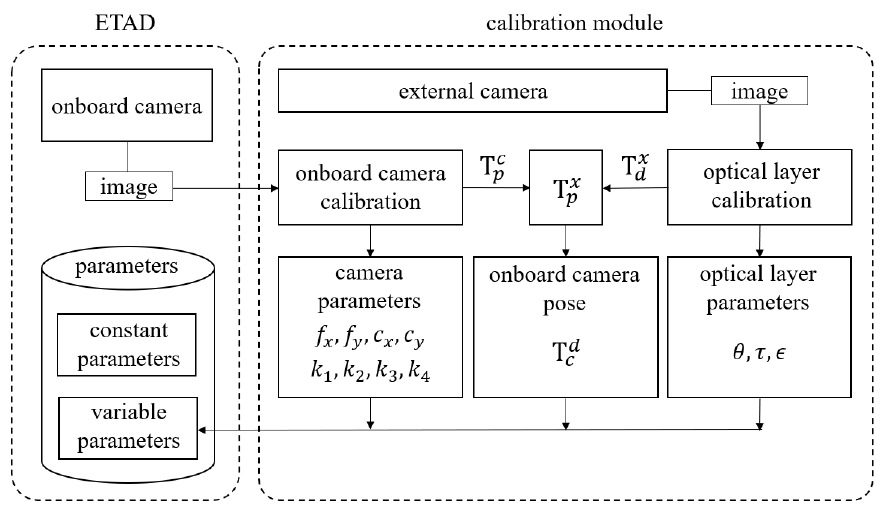
Figure 4. Block diagram of the calibration